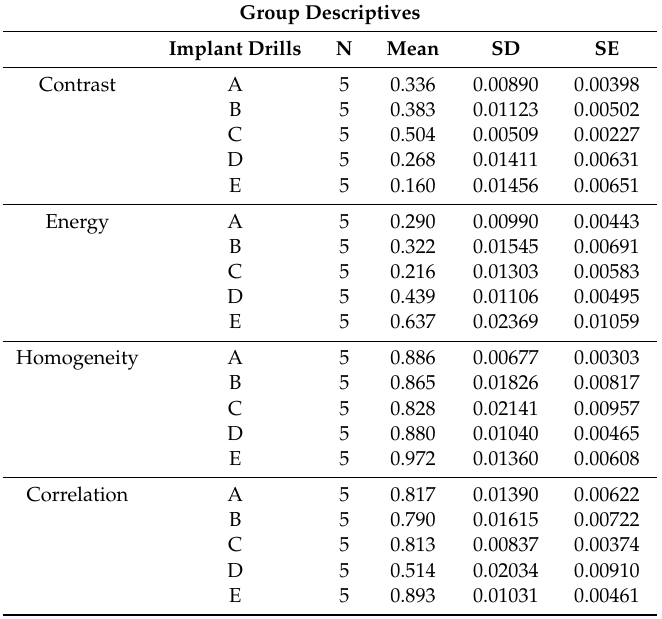
Table 3. Descriptives for the contrast, energy, homogeneity and correlation values of the implant drill microstructure images